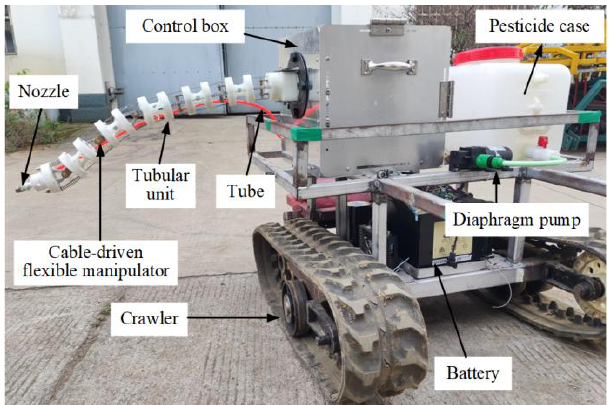
Figure 9. The prototype of the CDTSR. Table 3. Main technical parameters of the CDTSR.